Question: What form of chart is displayed?
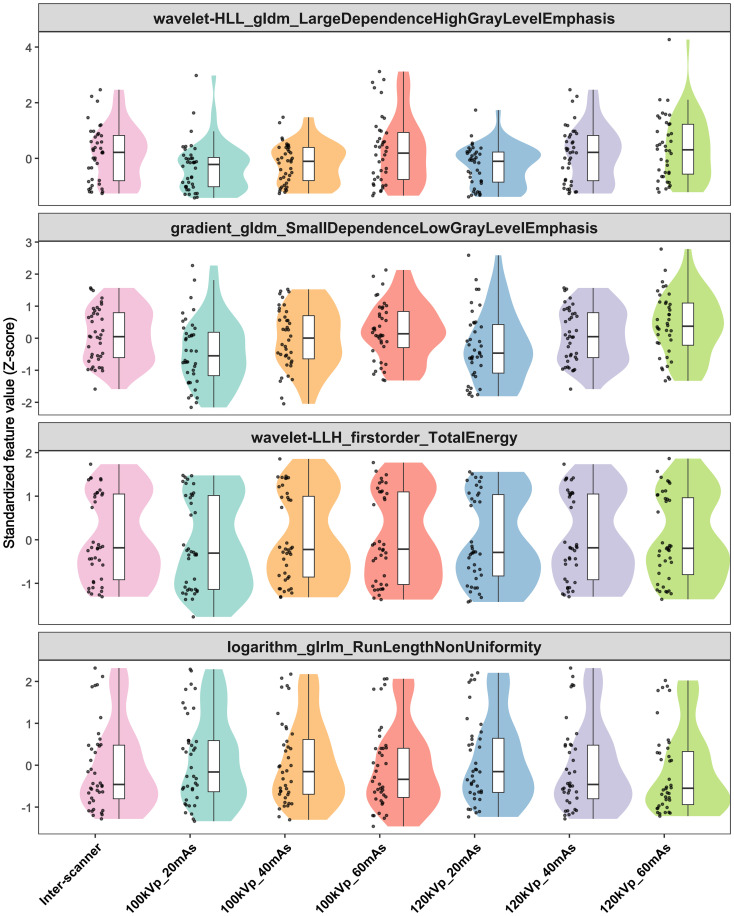
Answer: scatter